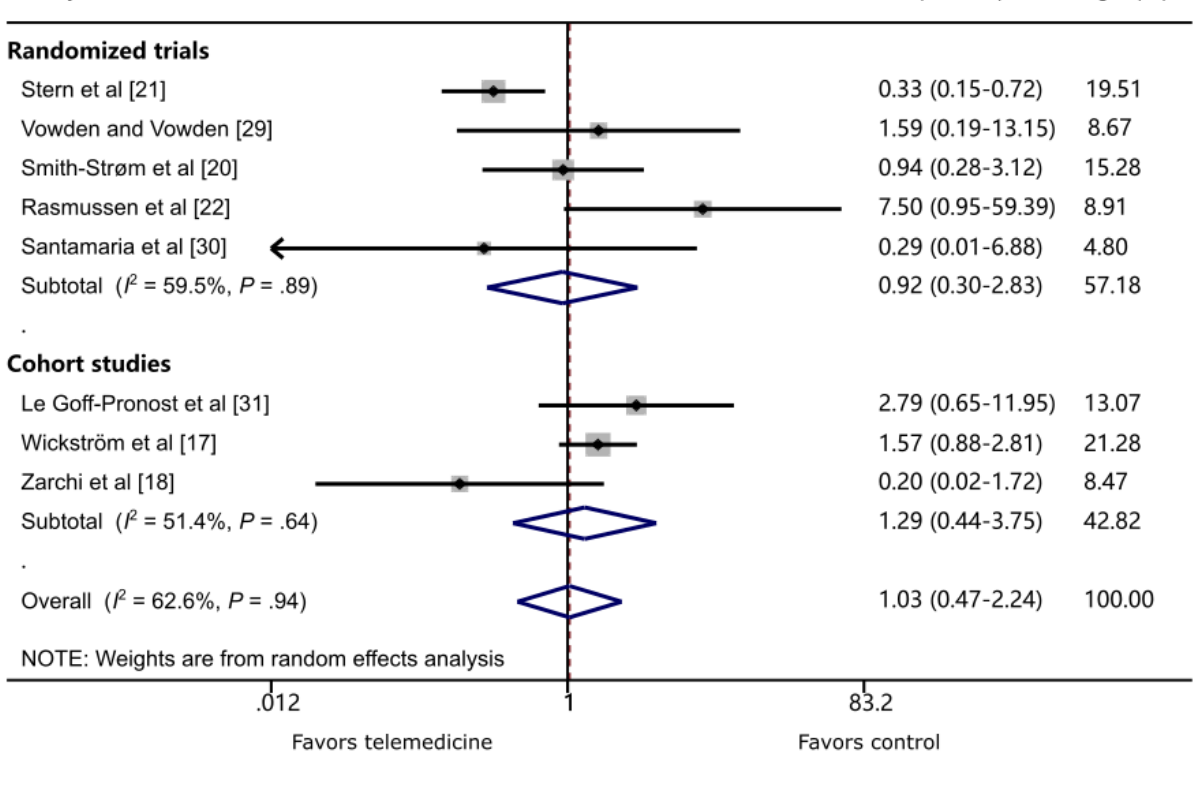
Figure 4. The effect of telemedicine on all-cause mortality. RR: risk